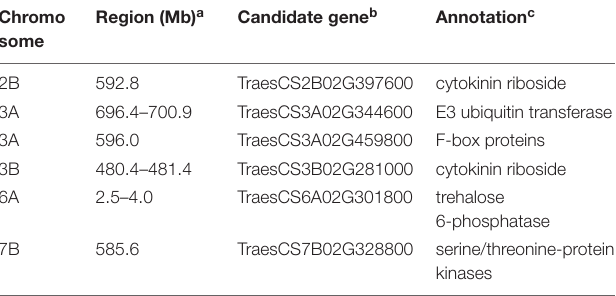
TABLE 3 | The details for the candidate genes of GY-related